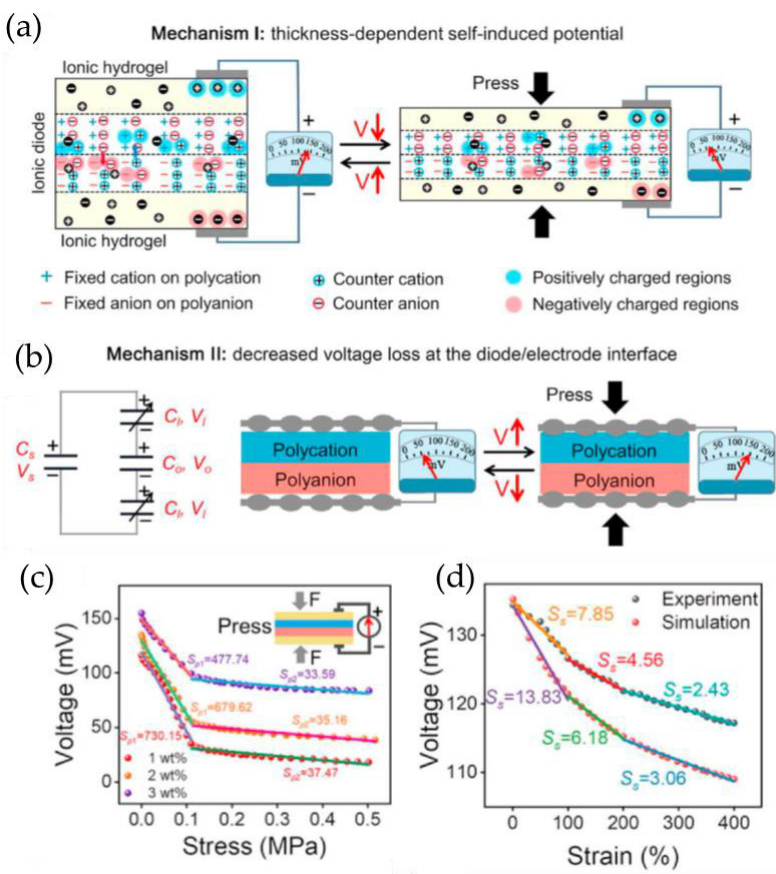
Figure 11. ( a ) Thickness-dependent self-induced potential of ionic diode. ( b ) Decreased voltage loss at the diode/electrode interfaces in response to pressure. ( c ) Output voltage and sensitivity of self-powered pressure sensors as a function of pressure. ( d ) Output voltage and sensitivity of self-powered sensors as a function of strain. (Reprinted with permission from